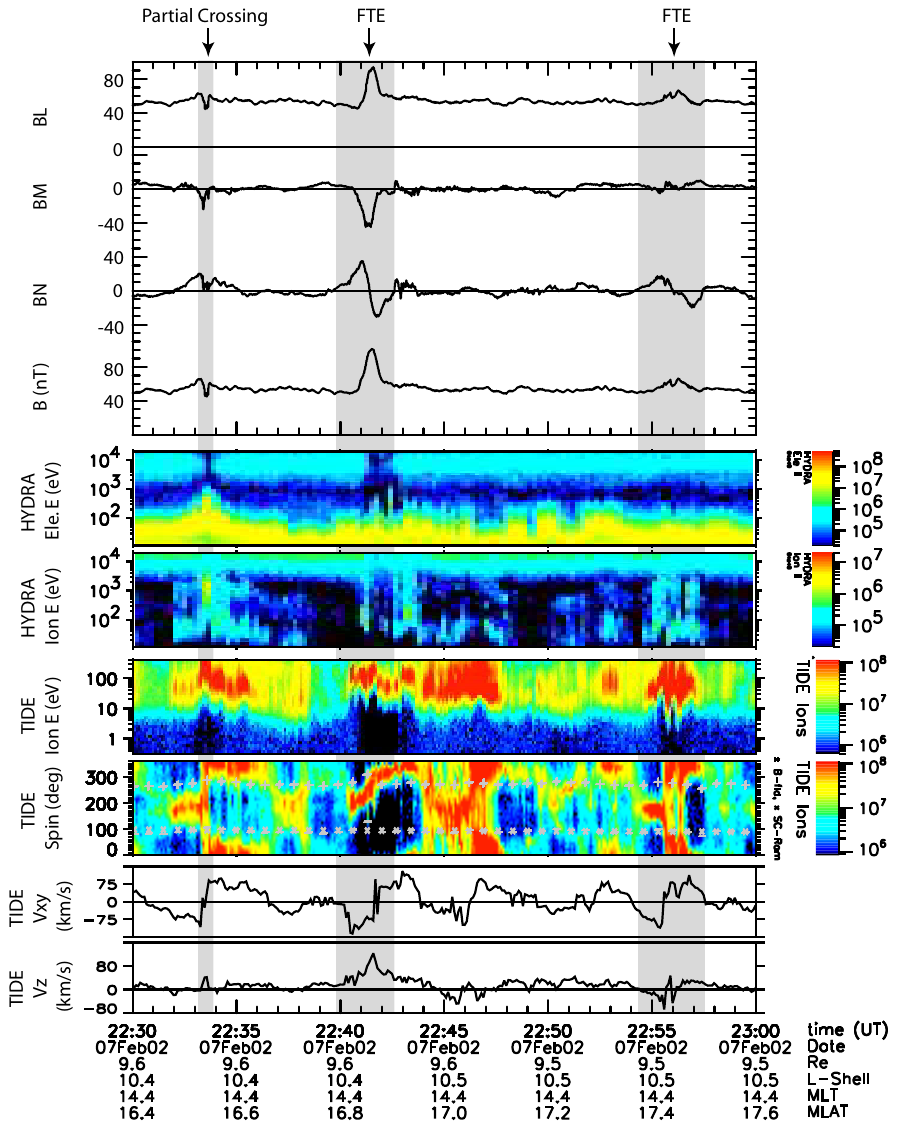
Fig. 13. High-resolution magnetic field data and plasma data from 22:30 to 23:00 UT showing two flux transfer events. The format is the same as Figs. 5a and b, except that the magnetic field data here are displayed in the local boundary normal